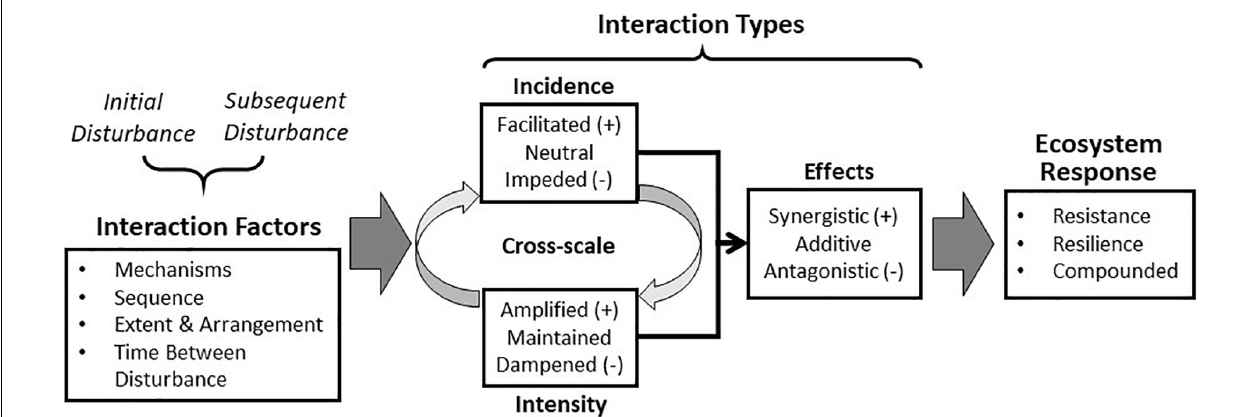
FIGURE 3 | The factors and processes specific to disturbance interactions. A series of interaction factors define the degree and strength of the disturbance interaction, which may manifest through one or more interaction types any of which may be positive, negative, or neutral. Feedback between interaction types (and also drivers; Figures 1 , 5 ) may manifest as cross-scale interactions . Ultimately, the effects of the disturbance interaction determine the ecosystem response ( Figure 5 ). Reprinted from Publication: Forest Ecology and Management Vol 405, Characterizing interactions between fire and other disturbances and their impacts on tree mortality in western U.S., p188–199, 2017, with permission from